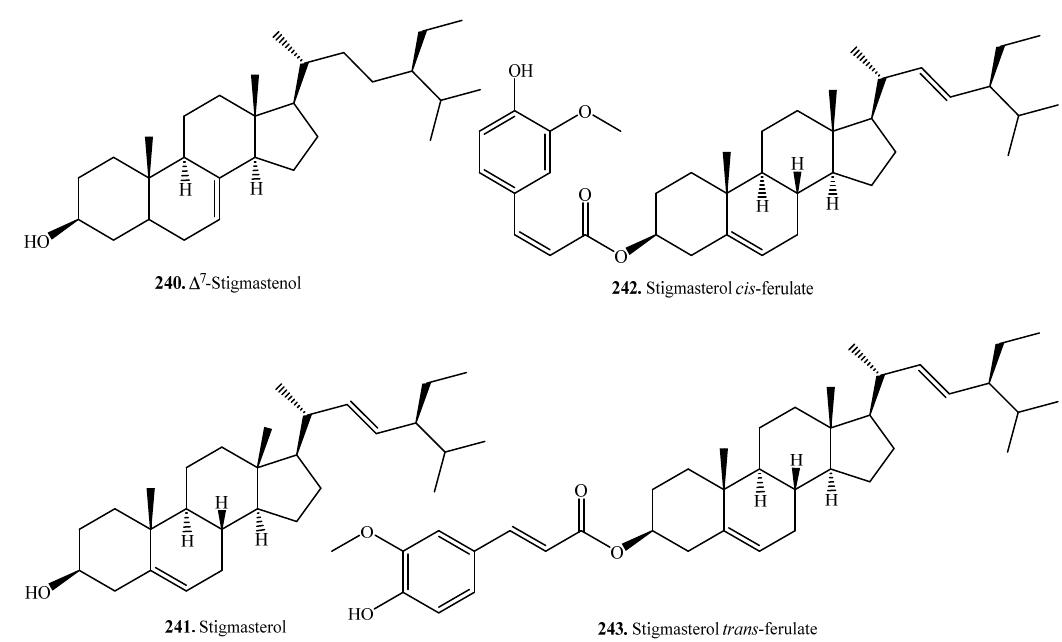
Figure 7. Structures of the steroids isolated from rice.